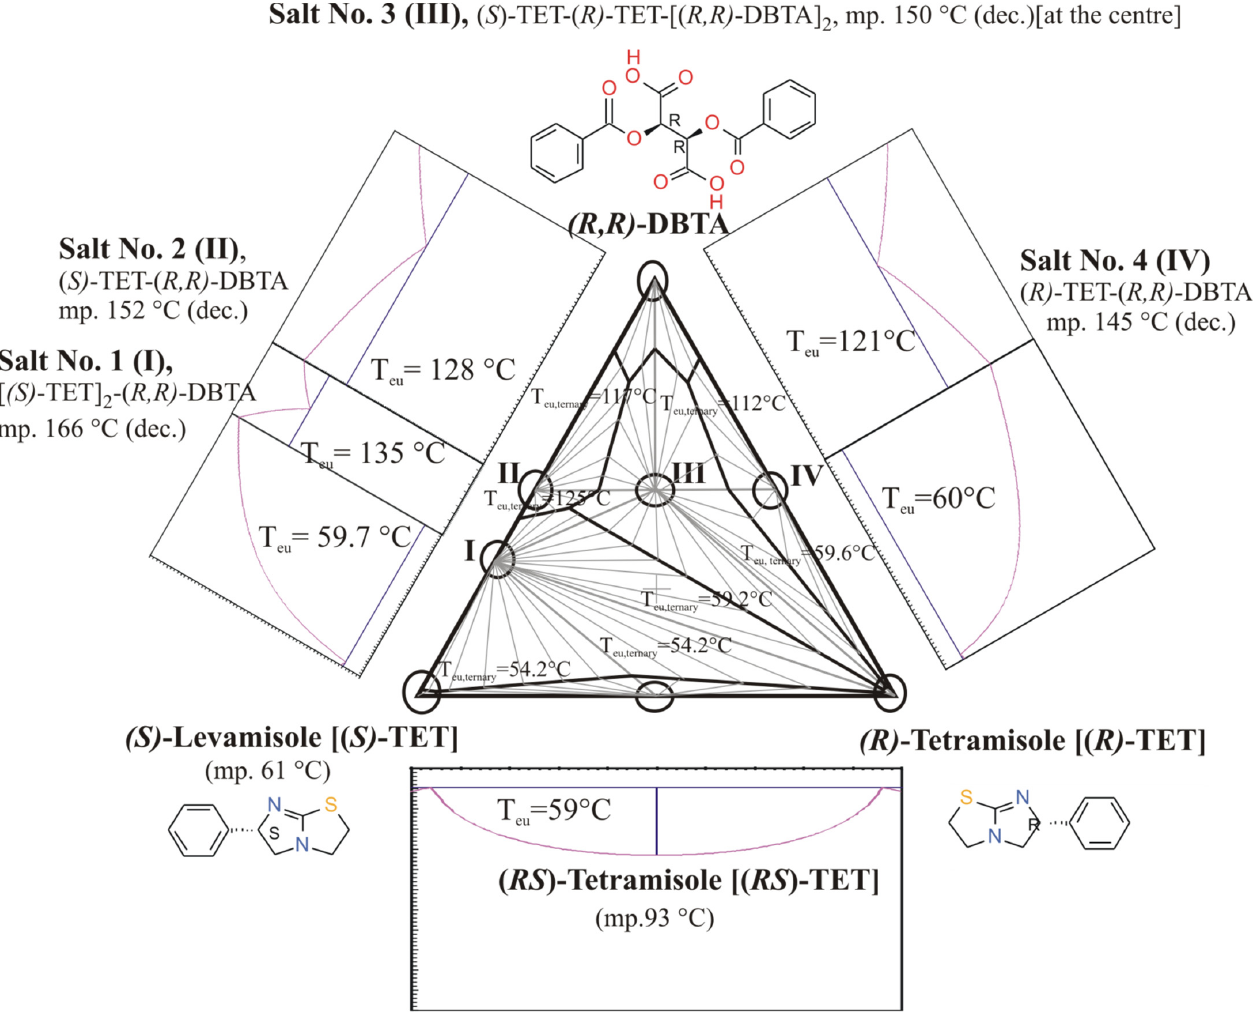
Figure 27. The overall ternary and some of the binary phase diagrams of (S )-Tetramisole (Levamisole)– (R )-Tetramisole– O , O ’-dibenzoyl- (R , R )-tartaric acid ( DBTA ) ternary system. Subternary systems are also defined by triplets of components, including the following solid crystalline compounds as racemic Tetramisole and four supramolecular salts (Salt Nos. 1–4, I —Salt No. 1, II —Salt No. 2, III —Salt No.3, IV —Salt No. 4), which are the co-crystallized compounds of the enantiomeric Tetramisoles and O , O’ -dibenzoyl- (R , R) -tartaric acid. The overall three-component T–x phase diagram has been assembled from ternary sub diagrams of the observed crystalline phase-associations assuming eutectic behavior among the crystalline solids and validity of Schröder–van Laar equations [4]. The bottom binary phase diagram of (R) - and (S) -Tetramisole corresponds to that given in Ref. [31]. (Figure recompiled/adapted from Ref. [13]. Copyright 2016, Elsevier B.V.).